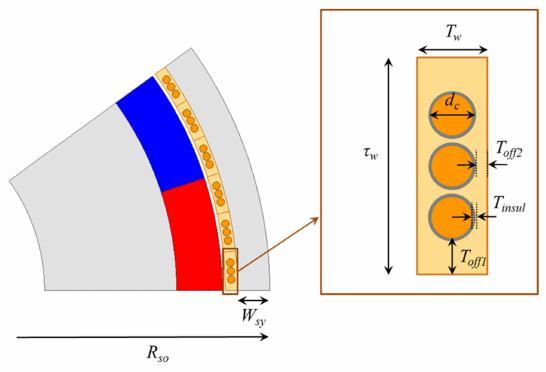
Figure 6. Geometry parameters of slotless